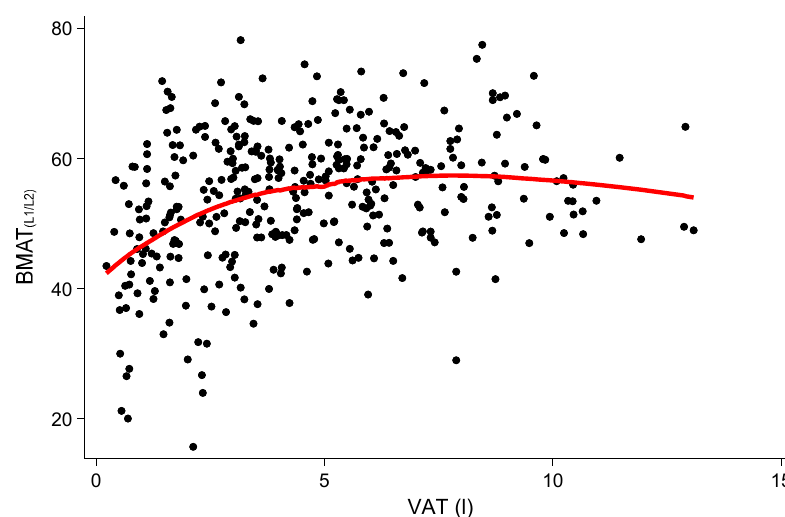
Figure 3. Local-weighted regression illustrated as a fitting curve. A potential saturation function can be argued between vertebral bone marrow adipose tissue (BMAT L1/L2 ) and visceral adipose tissue (VAT); the fitting curve was smoothed.